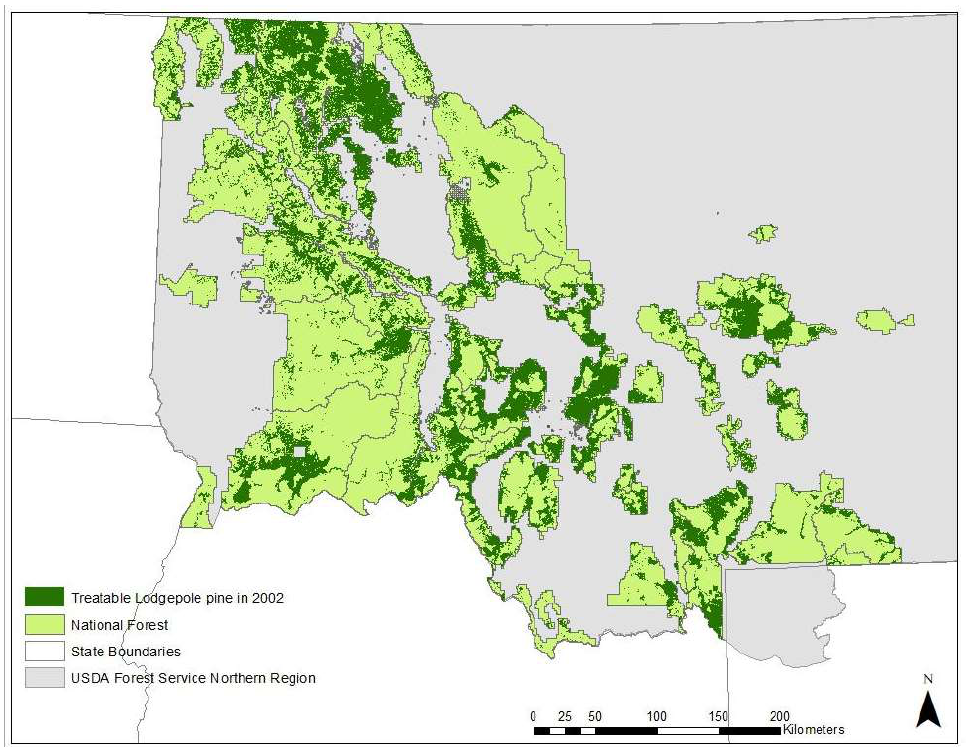
Figure 7. Spatial extent of land in the USDA Forest Service Northern Region in 2002 and the areas with a LPP probability of occurrence greater than or equal to 50% where tree removal is not prohibited by legal constraints.